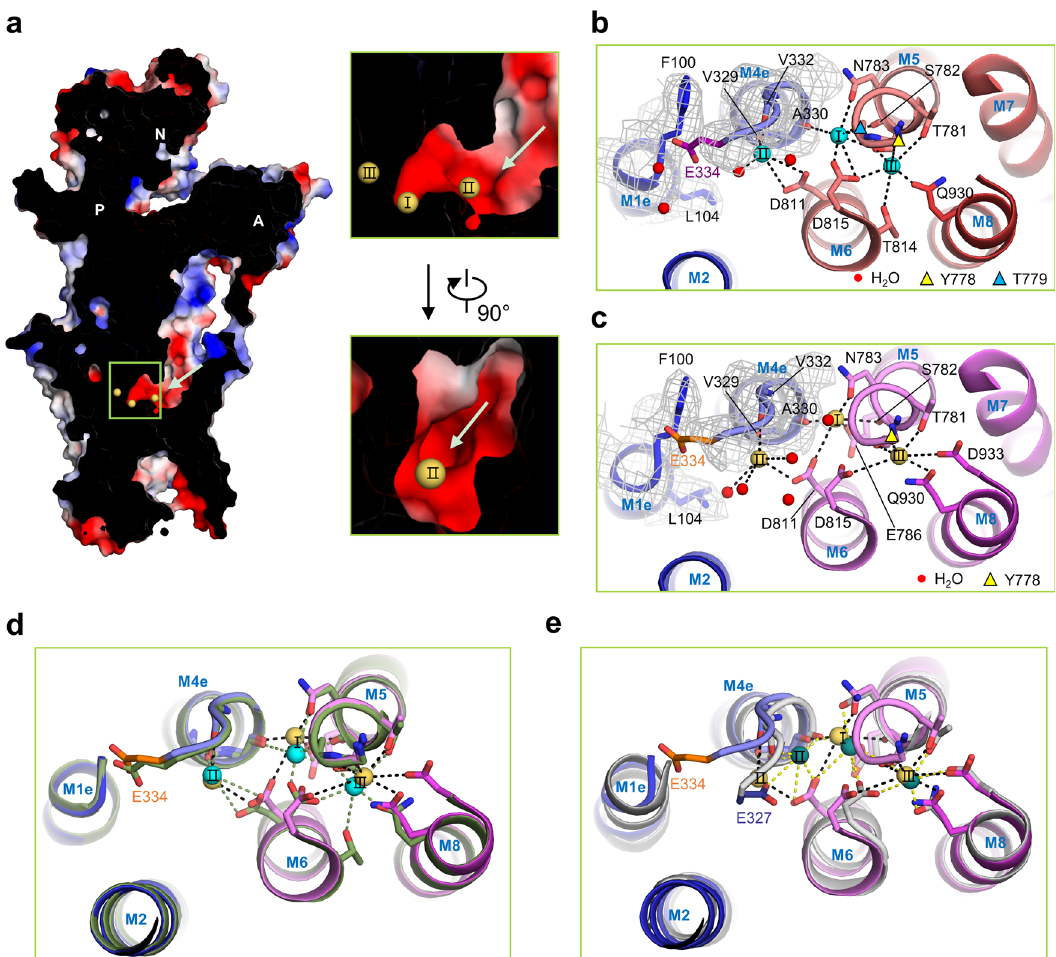
Fig. 2 Na + binding sites in different E1 states. a Cross-section through the Na + entry pathway in the E1·3Na·ATP state. Surface representation of the hNKA α 1 subunit is coloured by vacuum electrostatics. Na + are coloured yellow. b , c are the transmembrane Na + binding sites in the E1·3Na and E1·3Na·ATP states, with Na + (labelled I, II and III) shown in cyan and yellow, respectively. The EM density around gate residue Glu334 are shown in grey mesh. The key residues coordinated with Na + within 4 Å are shown in sticks and indicated by dashed lines. The water molecules are shown as red balls. The yellow and blue triangles represent Tyr778 and Thr779 above the pictured fi eld of view, respectively. d Binding mode comparison of Na + between the E1·3Na (dark green) and E1·3Na·ATP (spectrum from blue to magenta) states. e Binding mode comparison of Na + between the E1·3Na·ATP (spectrum from blue to magenta) and E1~P·[3Na]·ADP (grey) states. The gating residue Glu334 in human (Glu327 in pig) is coloured purple (E1·3Na), orange (E1·3Na·ATP), and slate (E1~P·[3Na]·ADP), respectively. Na + in E1~P·[3Na]·ADP are coloured deep teal. The structures in ( d ) and ( e ) are superimposed using M7 –